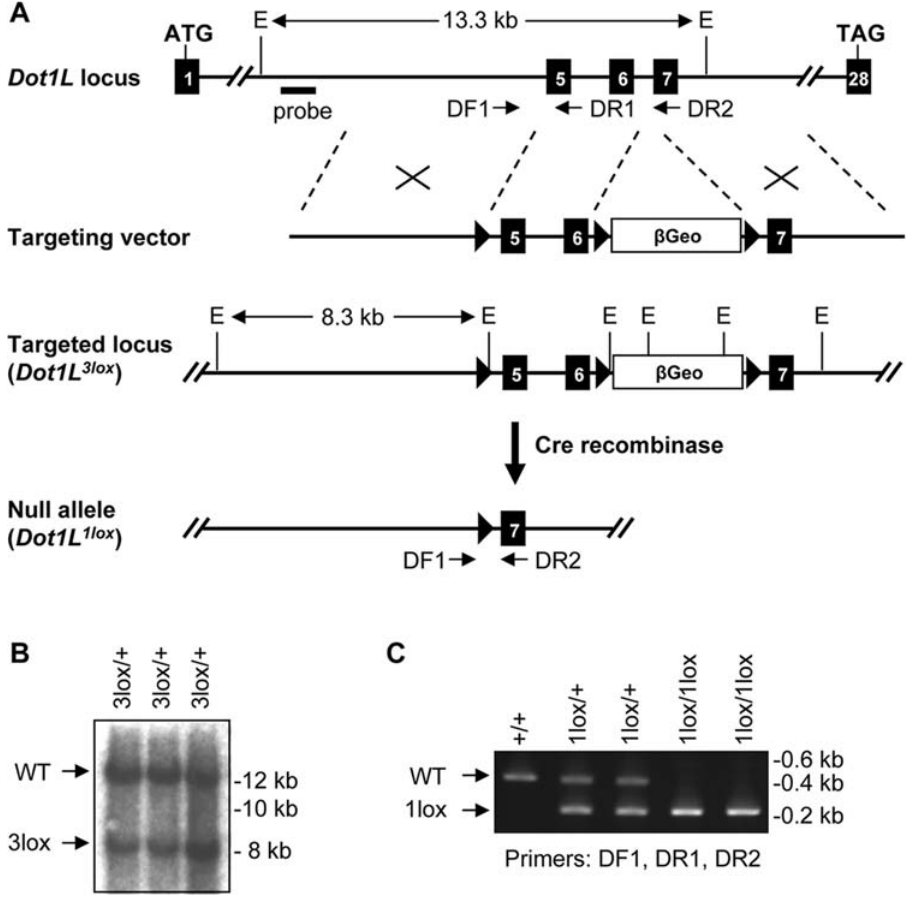
Figure 1. Generation of mutant Dot1L alleles in mice. (A) Schematic depiction of the strategy used to generate the Dot1L 3lox and Dot1L 1lox alleles. The exons are numbered. The locations of the Southern probe and PCR primers (DF1, DR1, and DR2) used for genotyping, as well as the sizes of the diagnostic fragments recognized by the Southern probe, are indicated (E, Eco RI). loxP sites are shown as triangles. (B) Southern blot analysis of Eco RI-digested genomic DNA probed with an 860-bp 5 9 probe external to the targeting vector. The presence of the 8.3-kb band confirms homologous recombination. (C) PCR genotyping of DNA from ES cells. WT, 485 bp; 1lox, 233 bp.